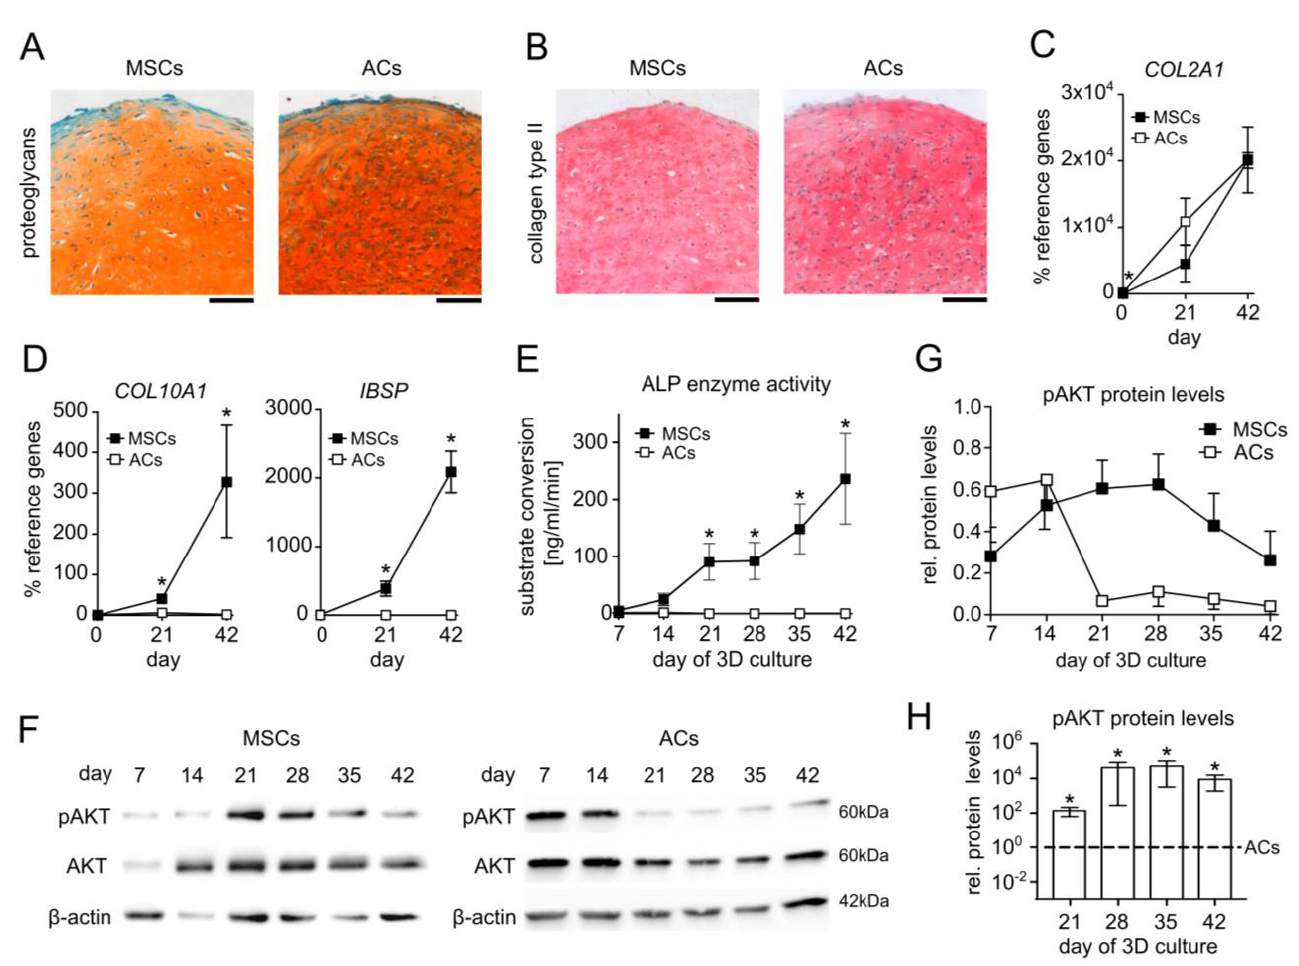
Figure 1. Inverse AKT regulation in hypertrophic MSC versus AC chondrogenic cultures. Pellets of expanded MSCs and ACs were subjected to chondrogenic culture for 6 weeks in the presence of TGFβ1 and insulin. Samples were harvested at the indicated time points 48 h after medium exchange. ( A , B ) Paraffin sections of MSC and AC pellets at day 42 stained with Safranin O/Fast Green to visualize proteoglycan deposition and for type II collagen by immunohistochemistry. Scale bars: 100 µ m. MSCs: n = 8, ACs: n = 5. ( C , D ) Gene expression analysis of the chondrogenic marker COL2A1 , the hypertrophic marker COL10A1 , and the osteogenic marker IBSP at days 0, 21, and 42 of MSC chondrogenesis and AC re-differentiation. RPL13 and CPSF6 were used as reference genes; n = 3. ( E ) Alkaline phosphatase (ALP) activity at weekly intervals was determined in culture supernatants pooled from four MSC or AC pellets for each independent experiment. MSCs: n = 6–7, ACs: n = 4. ( F ) Western blot analysis of pAKT and AKT protein using β -actin as loading control. One representative of n = 6–7 for MSCs from six independent donors and n = 4 for ACs is shown. ( G ) Densitometric analysis of Western blots shown in ( F ). ( H ) Densitometric analysis of Western blots: pAKT/ β -actin protein levels in MSCs and ACs at indicated time points were compared on the same membrane; n = 3. Given n-numbers refer to the number of experiments performed with independent MSC or AC donor populations. Means ± SEM are shown. * p ≤ 0.05 MSCs vs. ACs, Mann–Whitney U test